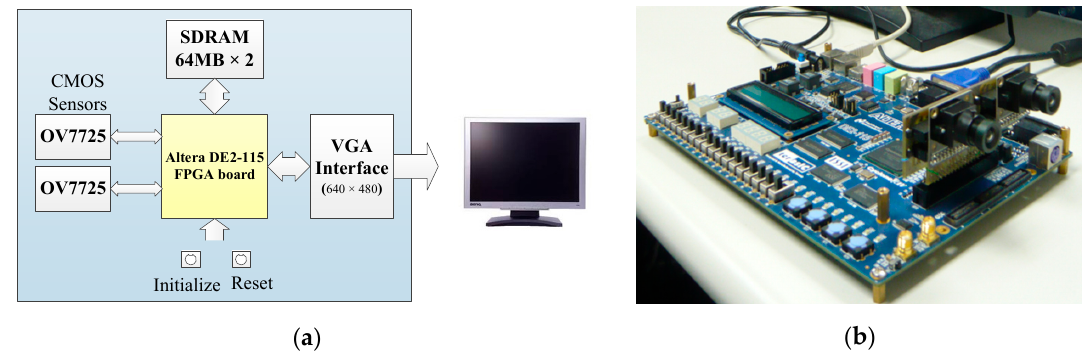
Figure 18. Hardware configuration of the embedded stereo vision system. ( a ) System hardware